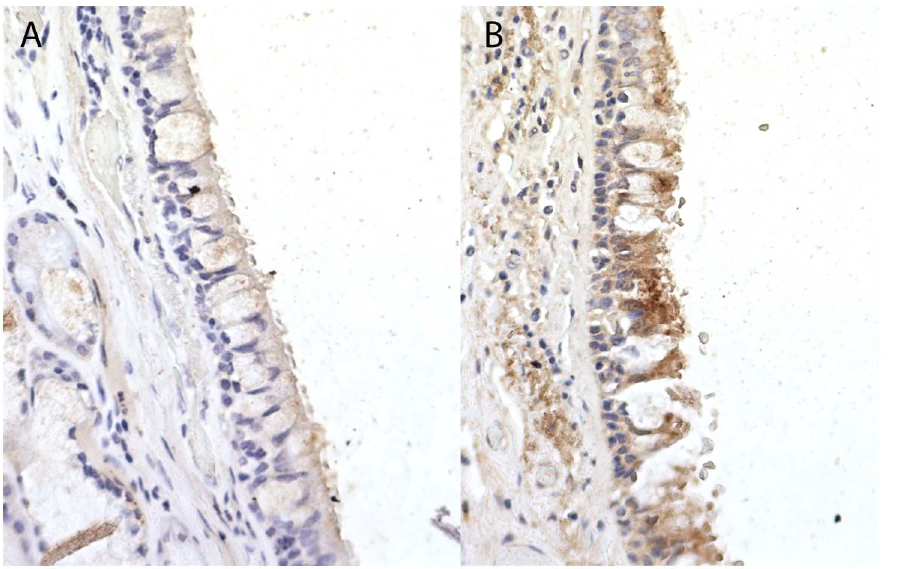
Figure 3. Immunohistochemistry staining for Coiled-Coil Domain-Containing Protein 38 (CCDC38) in a normal human bronchial epithelium at 6 40 magnification. When compared to the unstained isotype control (Rabbit IgG) (A), staining identifies moderate cytoplasmic expression of CCDC38 particularly in the columnar epithelial cells and the bronchial smooth muscle layer (B). Image representative of three independent staining procedures.